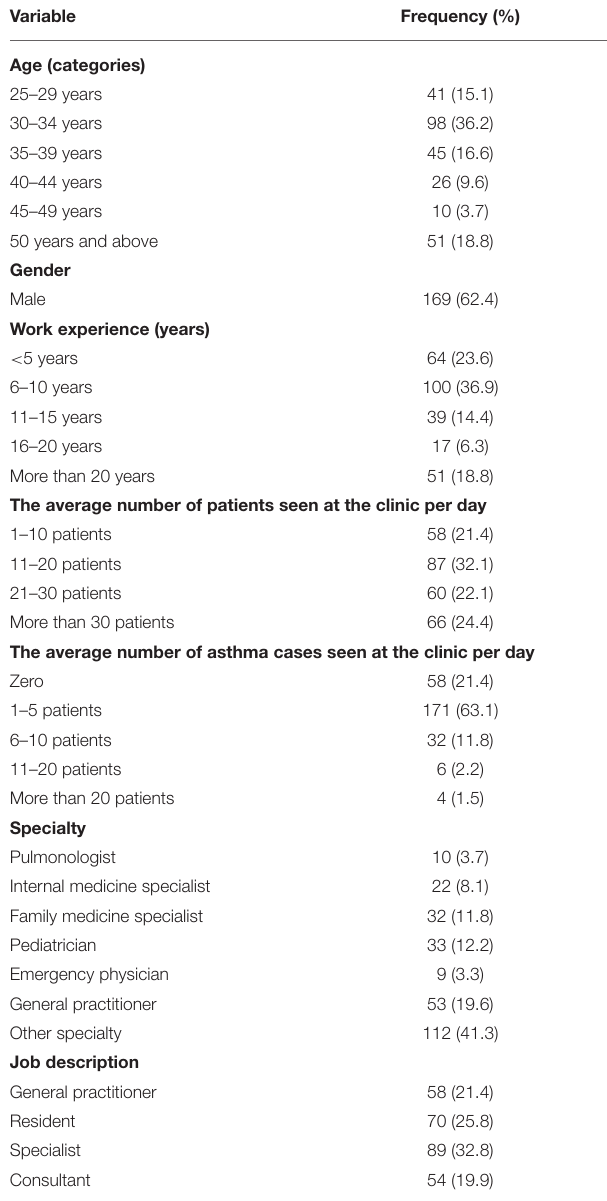
TABLE 1 | Demographic and practice’ characteristics for the study